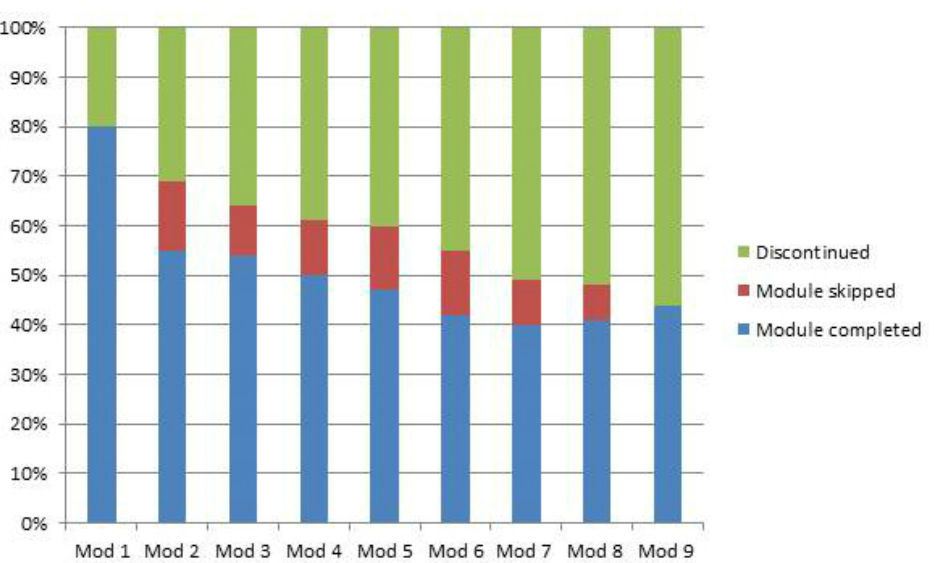
Figure 3. Module completion